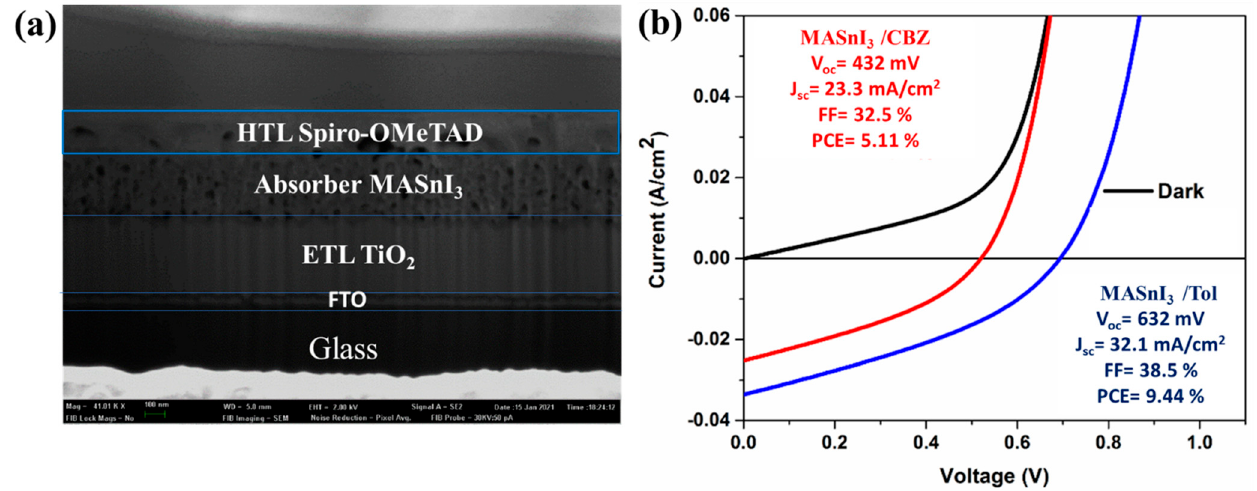
Figure 10. ( a ) Cross section of a lead-free perovskite solar cell. ( b ) I–V performance of perovskite MASnI 3 (black color = dark curves are identical for both devices, Red color = chlorobenzene, Blue color = toluene) ( b ) cross-section of a lead-free perovskite solar cell.